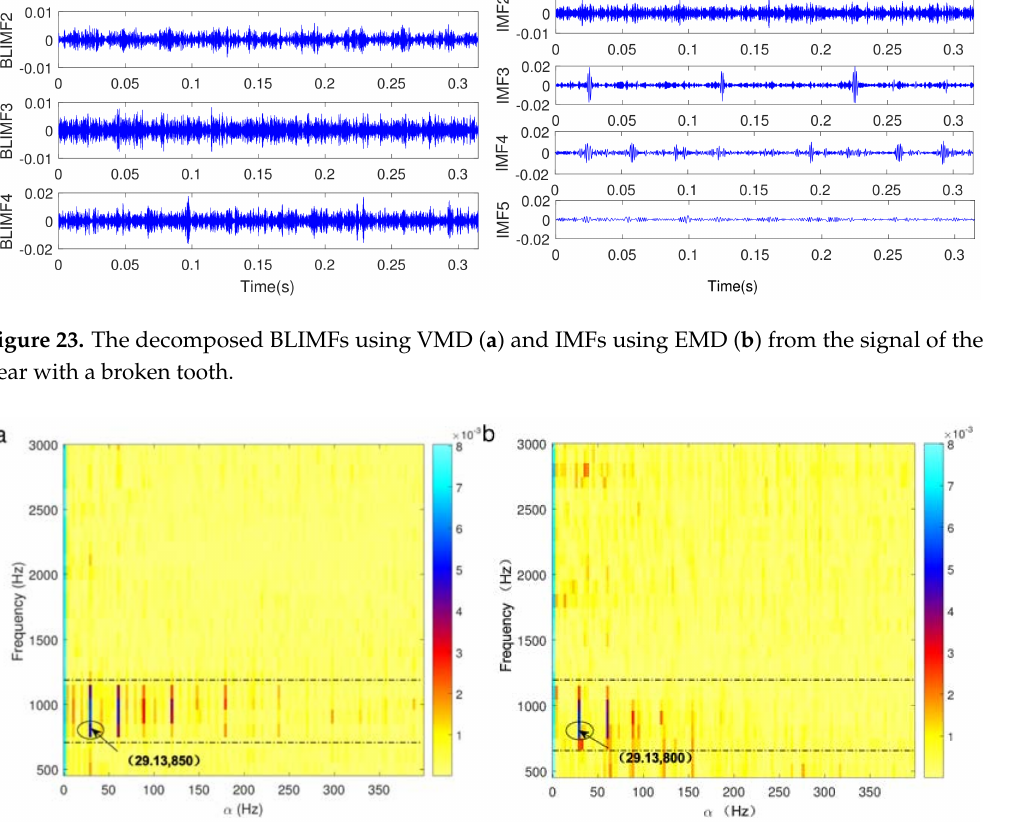
of BLIMF1 ( a ) and IMF3 ( b f